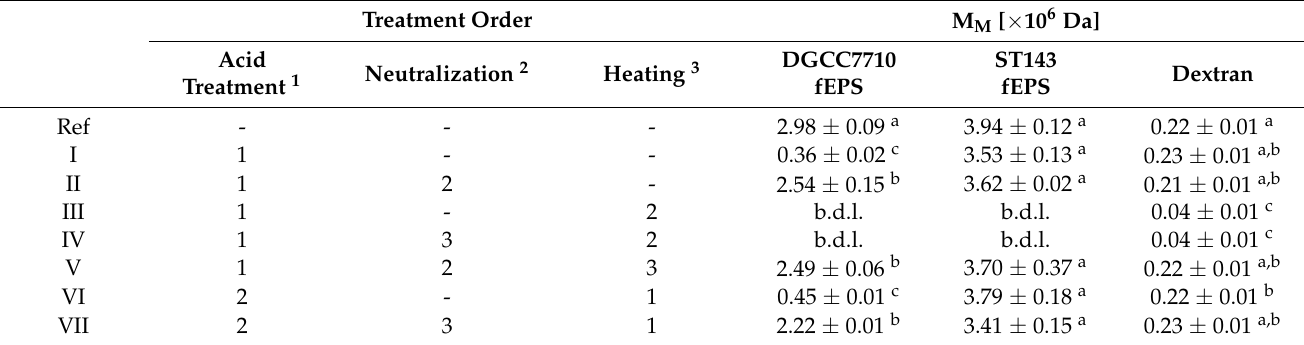
Table 2. Weight average molecular mass M M of EPS after thermal and acid stress of 1.0 g/L solutions in different treatment order. Ref: reference; b.d.l.: below detection level. Mean values with different superscripts in a column indicate statistical differences ( α =